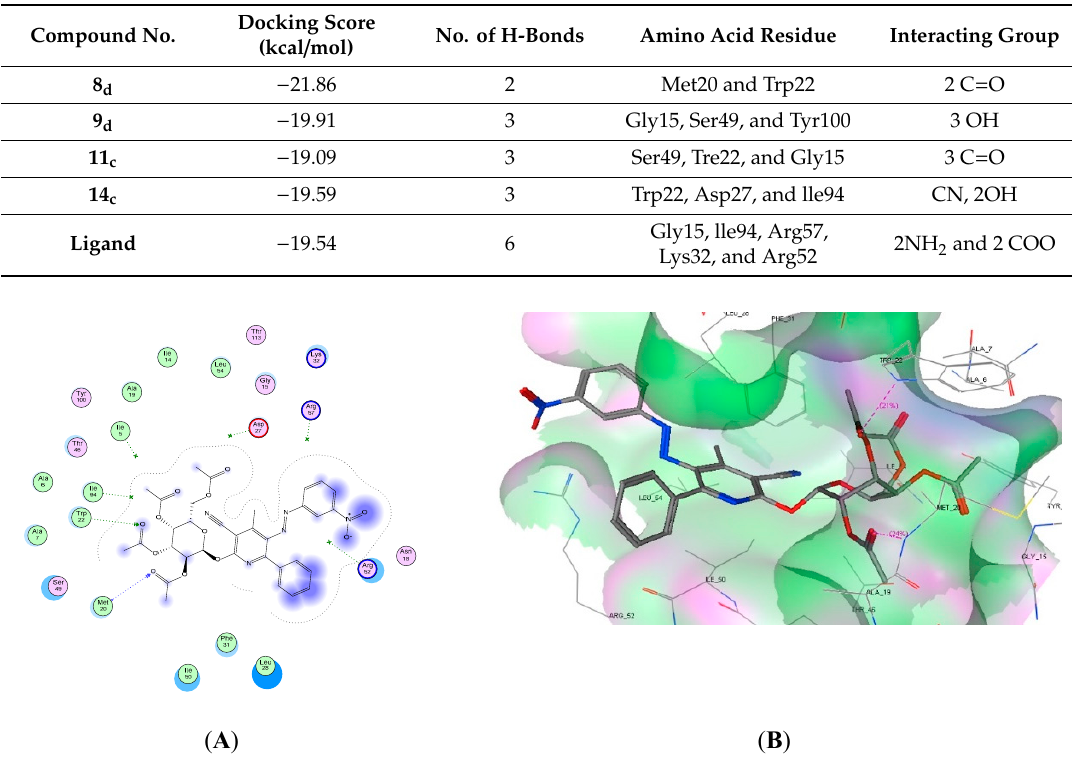
Figure 2. ( A ) 2D interactions of compound 8 d with the DHFR binding site. ( B ) 3D interactions of compound 8 d with the DHFR binding site.